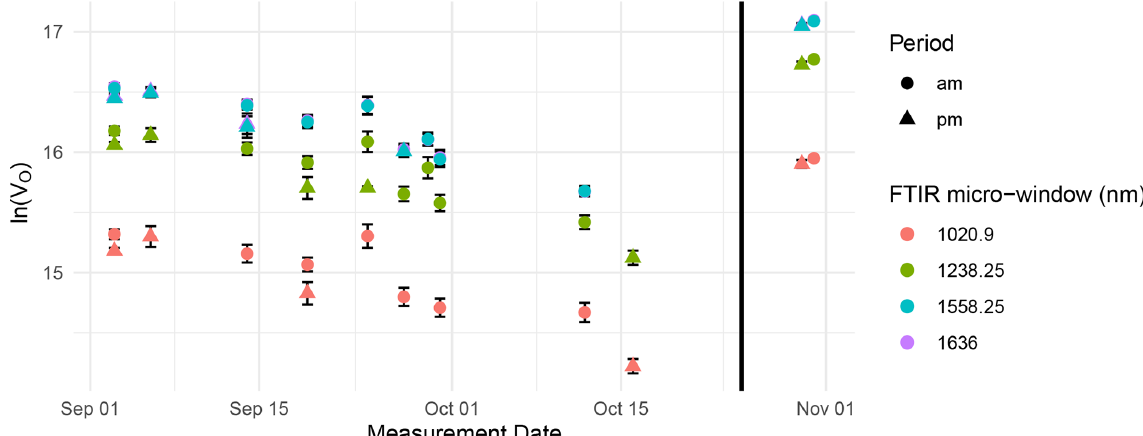
Figure B1. Absolute calibration for the Langley exponential analysis of the EM27/SUN solar spectra over time from September to November 2020. Mirrors became significantly dirtier and dustier over the course of the measurement period. The ln( V o ) increased considerably after the instrument mirrors were cleaned once the field campaign ended (black line).